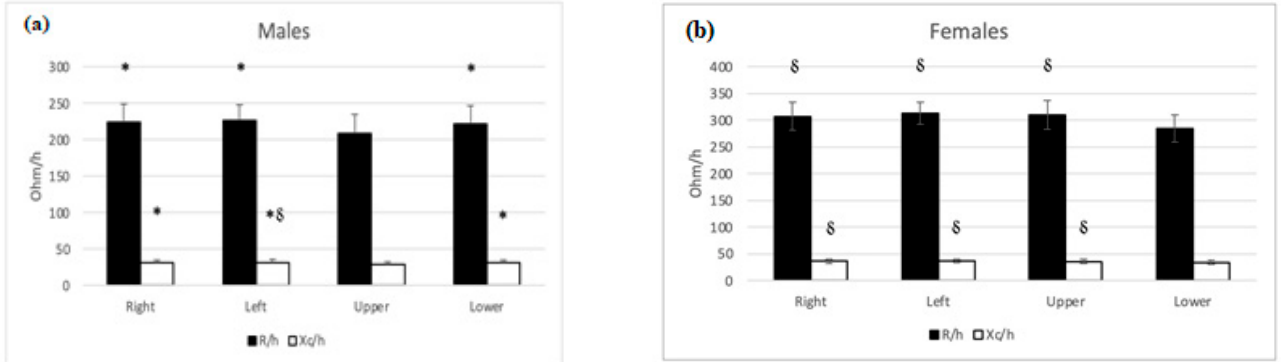
Figure 2. Bioelectrical characteristics of the sample for both sexes, for right and left sides and upper and lower body. ( a ) males. ( b ) females. caption: R/h = resistance/height; Xc/h = reactance/height. * Significantly different from the corresponding upper body bioelectrical parameter; § Significantly different from the corresponding lower body bioelectrical parameter.